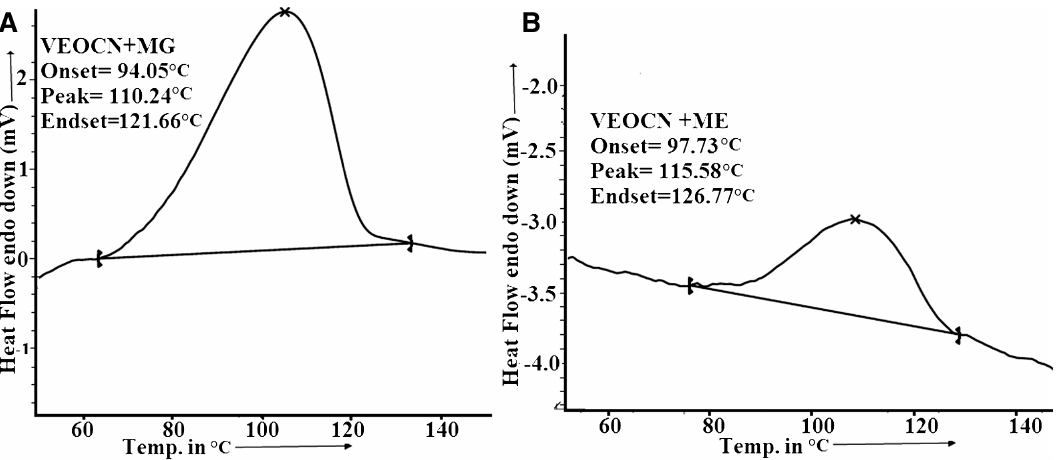
Figure 6: Typical DSC scans for curing at 10 ° C/min of VE resin samples (A) VEOCN + MG and (B) VEOCN + ME.